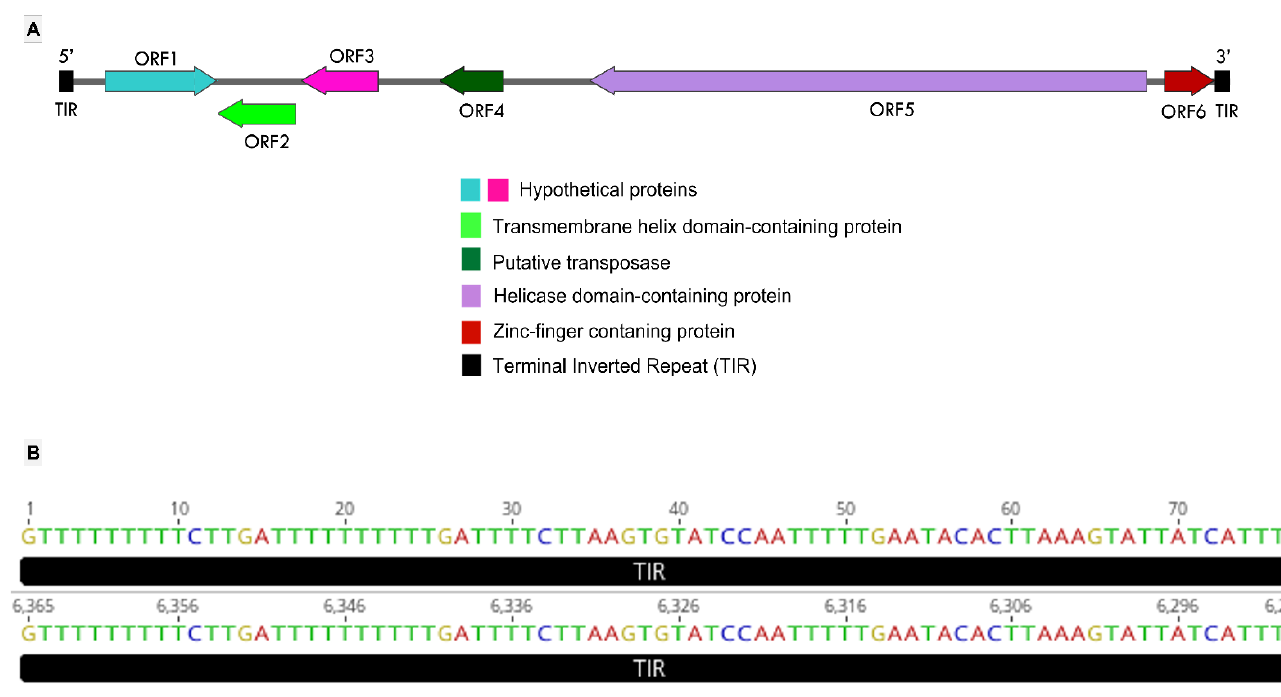
Figure 4. The mimivirus argentum transpoviron genome. ( A ) Mimivirus argentum-associated transpoviron genome map showing the six predicted ORFs and the respective annotation, coded by different arrow colors, as shown in the legend above. Right-directed arrows represent positive strand ORFs, and left-directed arrows represent negative strand ORFs. Terminal inverted repeats (TIRs) are represented by black squares. ( B ) Representation of mimivirus argentum transpoviron TIRs by black arrows, showing the inverted match (100%) of its nucleotides and its position in the genome. The 3′ TIR (6289 – 6365 nt) is represented by its reverse complement.